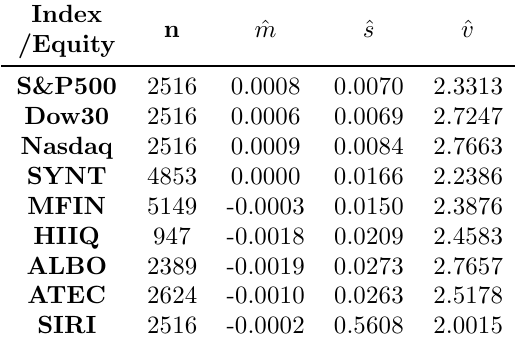
MLE for t-student